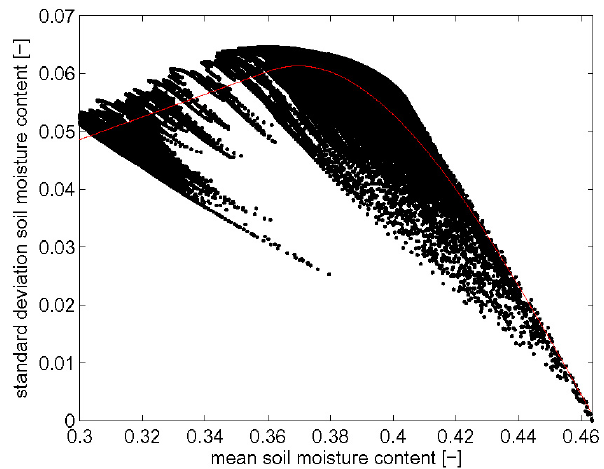
Fig. 3. Fitted spline with 4 knots (red), between mean soil mois- ture content values and their standard deviation (black dots) for the agricultural field